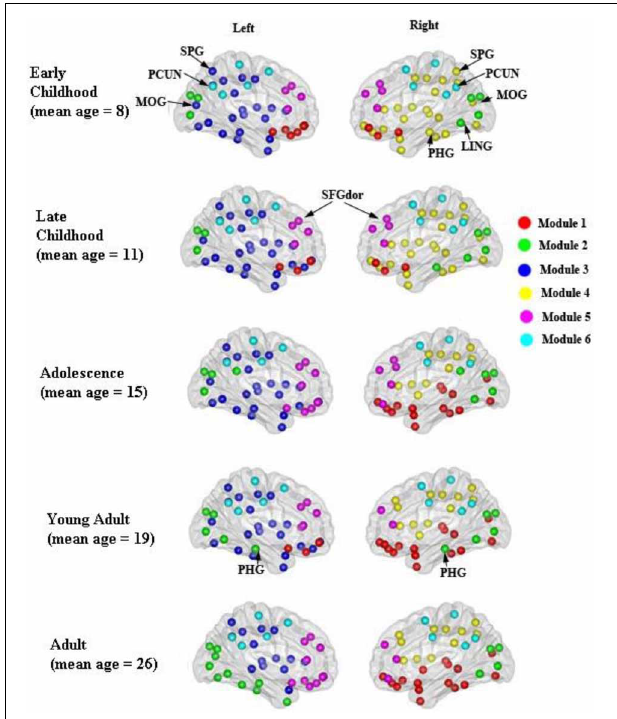
FIGURE 7 | Modular organization of the developing WM networks. Six modules (1–6) were detected in all age groups and are represented by red, green, purple, yellow, pink, and blue colors. See Table 3 for a detailed list of modular regions. Module 1 was mostly composed of bilateral orbitofrontal regions (ORBsup, ORBsupmed, ORBmid, REC) in early and late childhood and becomes more lateralized from adolescence onwards. Module 2 consists of mostly occipital regions (SOG, CAL, CUN) bilaterally. Lateralized modules 3 (left hemisphere) and 4 (right hemisphere) consist of regions mostly across frontal, parietal and temporal lobes within each hemisphere. Modules 5 and 6 are two of the most consistent modules during development that include mostly bilateral frontal (SFG, MFG) and posterior parietal (PCUN, DCG, SMA) regions, respectively.